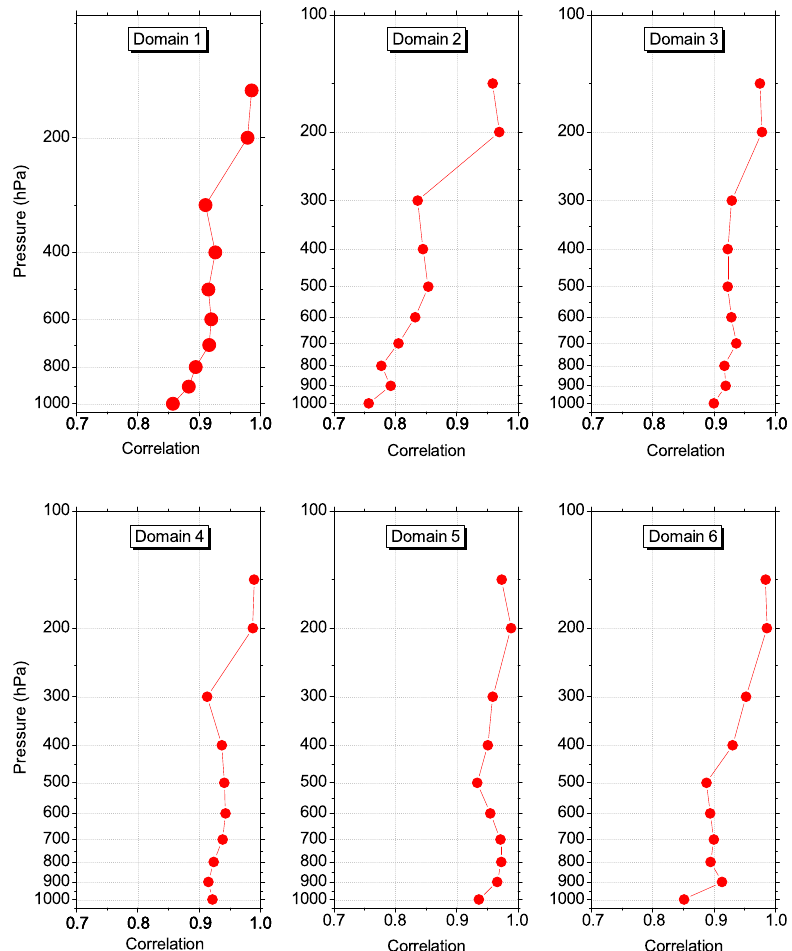
Figure 16. Same as Fig. 14 but for the correlation coefficient between both analyses (TOTCOL_ANALYSES and PROFILE ANALYSES).